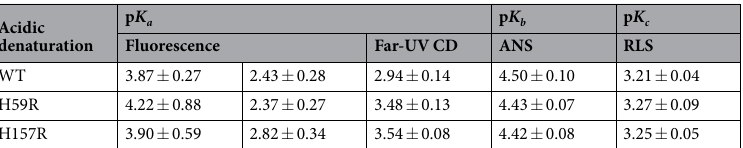
Table 2. Fitted parameters for the acidic unfolding of Pin1-WT, H59R and H157R. p K a , the pH of the denaturation process at the midpoint. p K b , the pH of one half of full exposure by ANS spectra. p K c , the pH of the maximum intensity at 450 nm by RLS spectra. + The two-step transitions were used to analyze the unfolding of Pin1-WT, H59R and H157R, from pH 7.0 to pH 3.0 and from pH 3.0 to pH